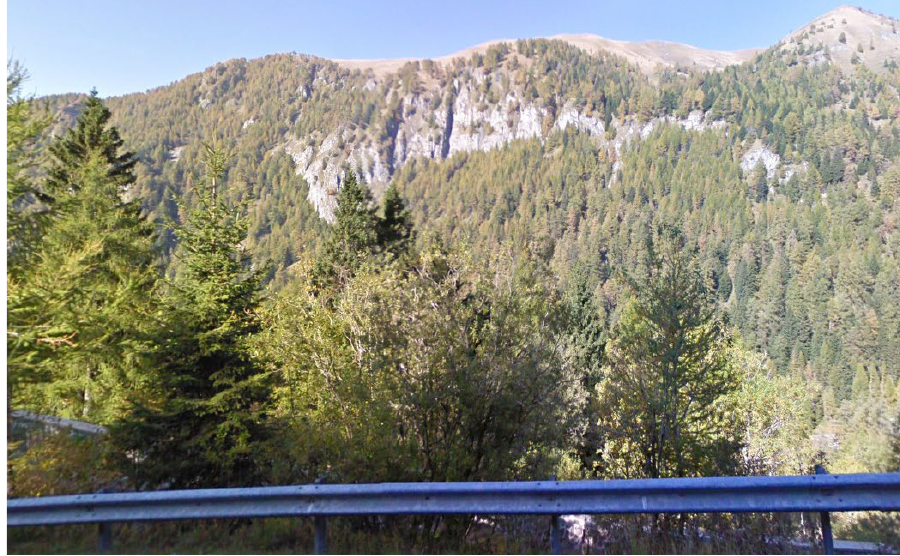
Figure 4. Photo of the study area shot from the opposite side of the valley, along SP 345 provincial road; the rock faces are clearly visible. Table 1. The four joint sets recognized in the rock mass of the study area.